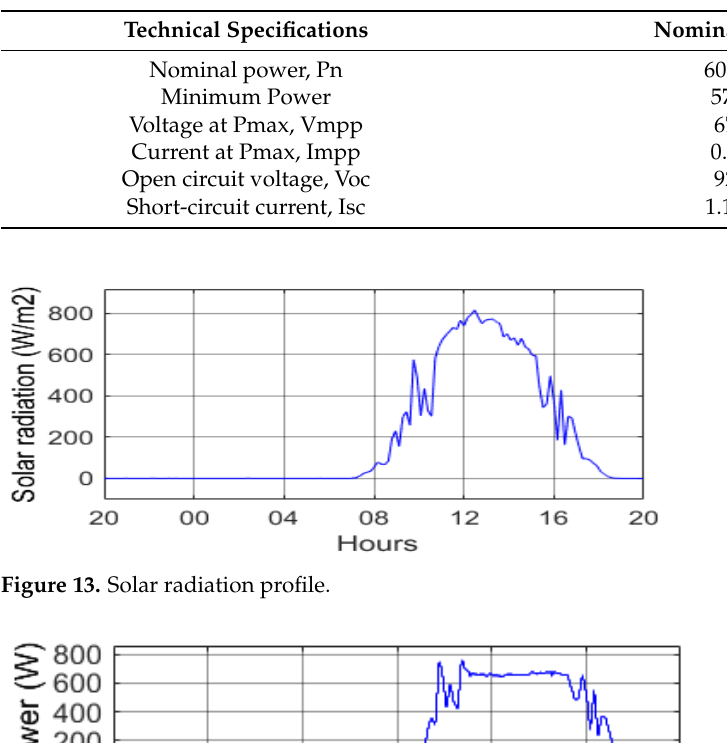
Table 6. Main parameters of the PV module Kaneka GSA060.